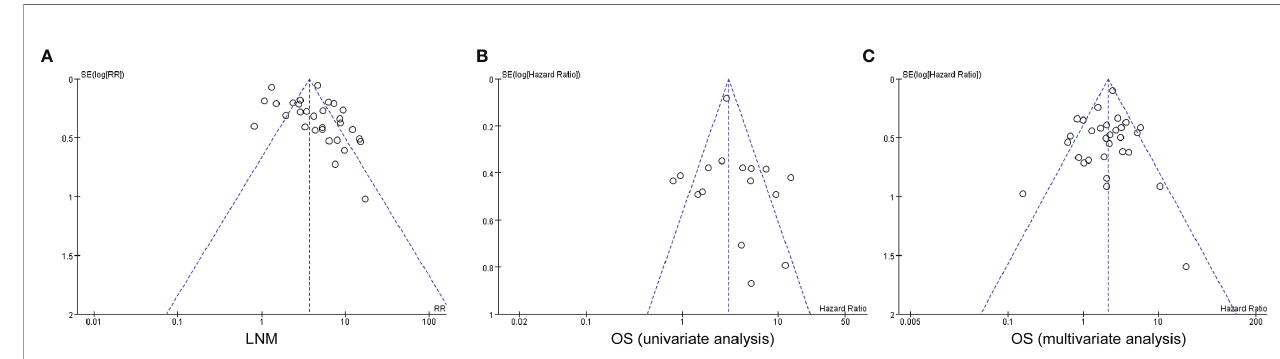
FIGURE 5 | Funnel plots for potential publication bias. Funnel plot analysis of lymph node metastasis (A) , and univariate and multivariate survival analyses (B, C) . LNM, lymph node metastasis; OS,